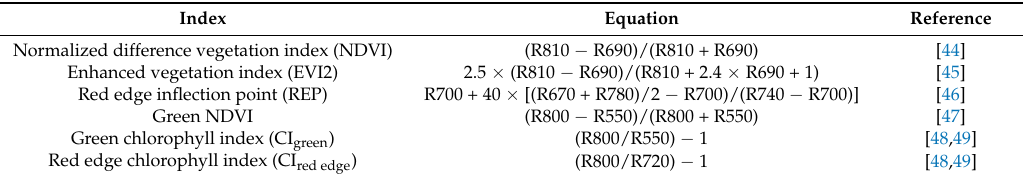
Table 3. Vegetation indices used in this